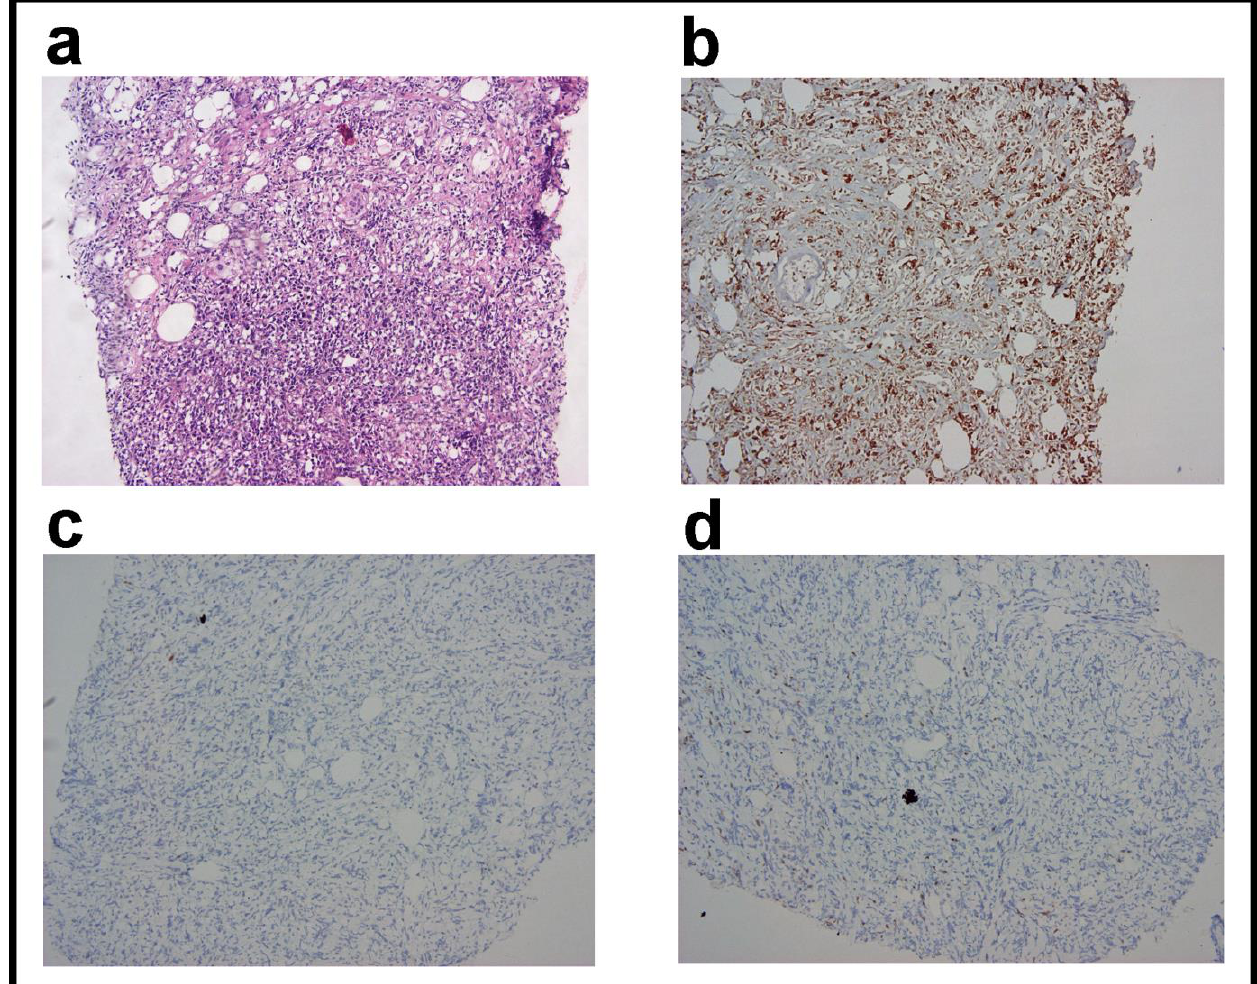
Figure 1. Hematoxylin and eosin and immunohistochemistry staining of biopsy from the parapharyngeal mass. a) Hematoxylin & eosin b) Myeloperoxidase c) CD20 d)